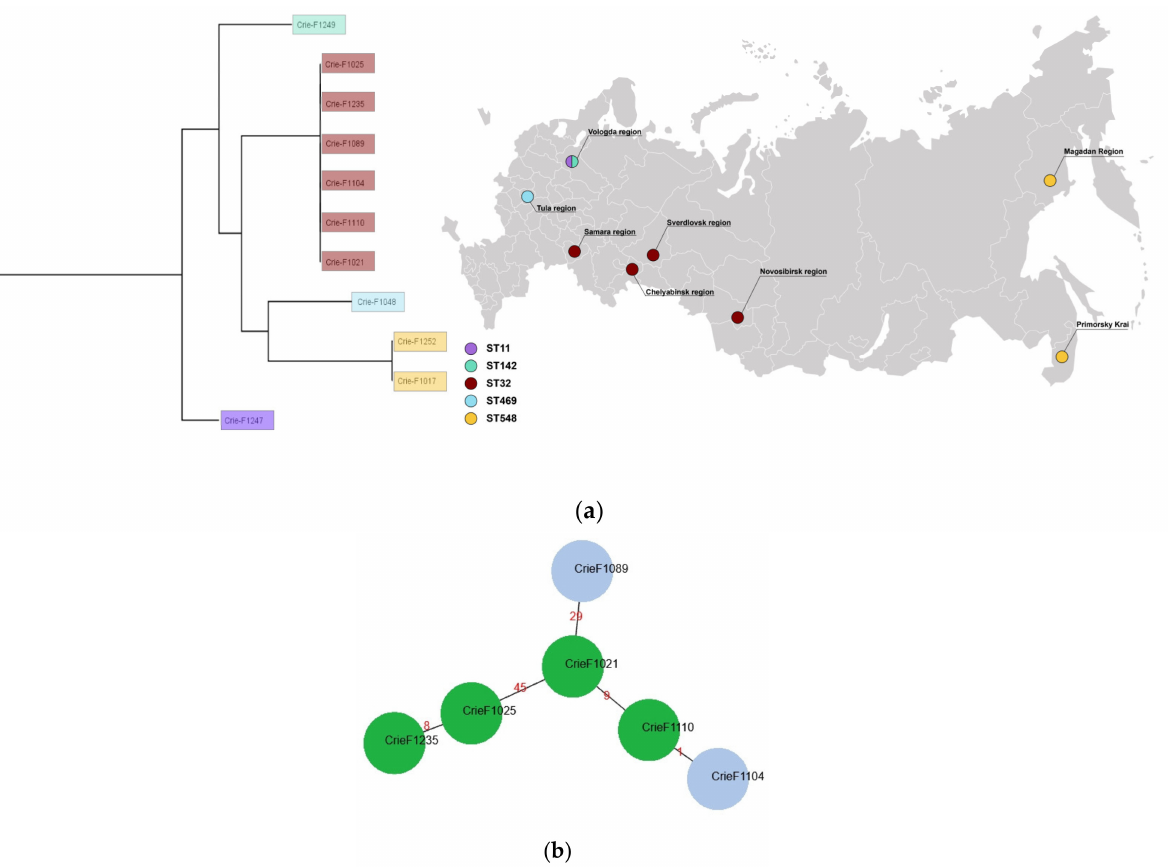
Figure 1. ( a ) Typing, geography, and phylogenetic analysis of CIP-3rd food S. enterica isolates studied. ( b ) A minimum spanning tree for CIP-3rd food S. enterica isolates with ST32. Red numbers indicate alleles discrepancies. The isolates for which the hybrid assemblies are available are shown in